Question: In one sentence, what is this figure communicating?
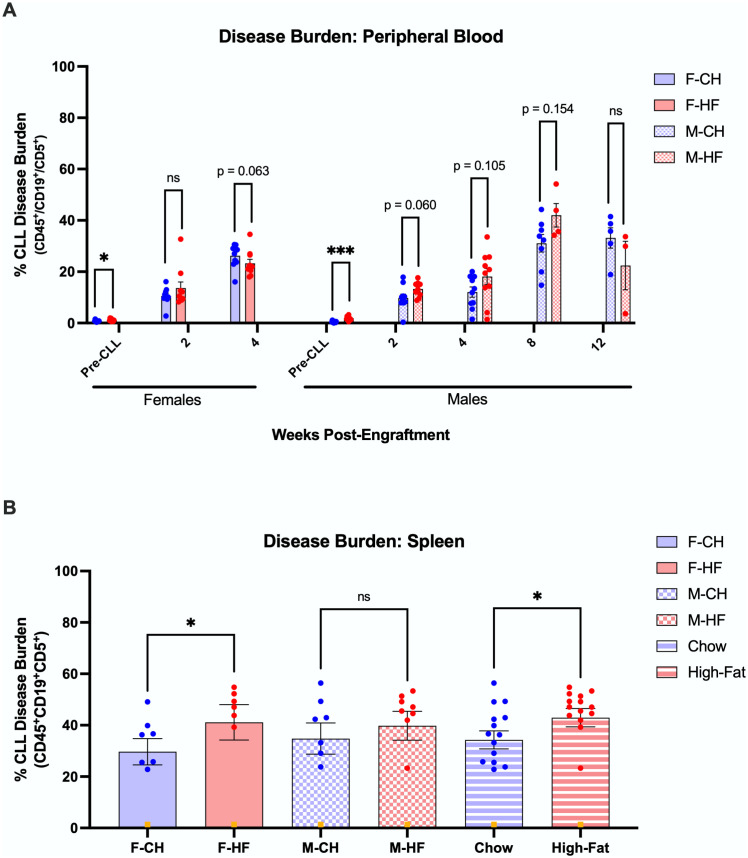
Answer: Expansion of CLL in the peripheral blood and spleens of diet study mice. (A) CLL disease burden was measured by percentage of CD45+/CD19+/CD5+ cells in the peripheral blood via flow cytometric analysis beginning prior to CLL engraftment. Females were additionally monitored at 2-weeks post-engraftment and 4-weeks post-engraftment (F-CH, n = 10; F-HF, n = 10). Males were additionally monitored at 2-weeks post-engraftment, 4-weeks post-engraftment, 8-weeks post-engraftment, and 12-weeks post-engraftment (M-CH, n = 10; M-HF, n = 10). Asterisks denote the significance between diets at each time point (* p < 0.05, *** p < 0.001). Unpaired, Mann-Whitney U tests were used to determine significance between two groups. (B) CLL disease burden was measured by percentage of CD45+/CD19+/CD5+ cells in the spleen via flow cytometric analysis at end of study (i.e., when mice became moribund and sacrificed). Asterisks denote the significance between diets at each time point (* p < 0.05). Unpaired, Mann-Whitney U tests were used to determine significance between two groups. F-CH, female chow; F-HF, female high-fat; M-CH, male chow; M-HF, male high-fat. Yellow squares represent WT B6 controls.